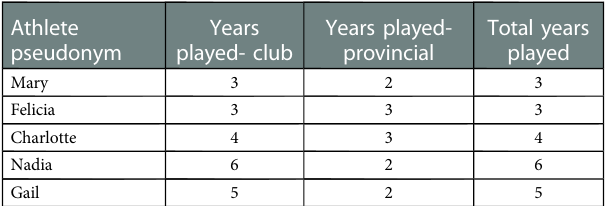
TABLE 1 Summary of playing